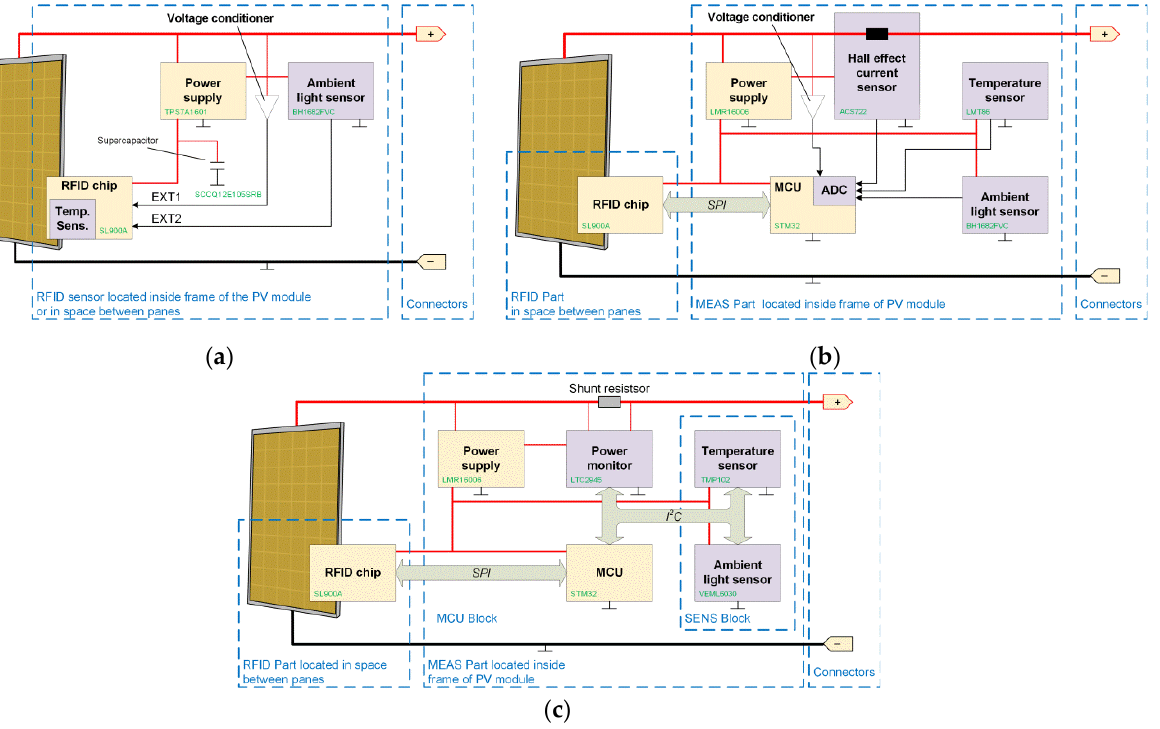
Figure 5. Block diagram of RFID transponder-sensor concepts: ( a ) device based on RFID chip; ( b ) device with microcontroller and analog sensors; ( c ) device with microcontroller and digital sensors.